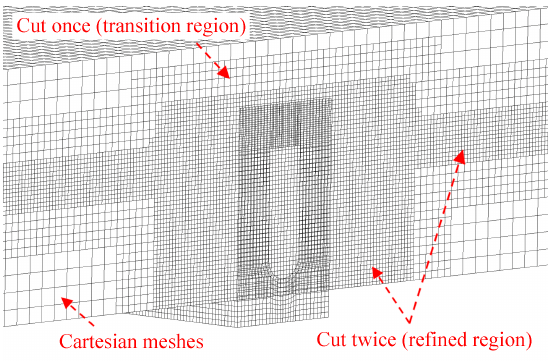
Figure 7. The cut-cell elements in transition region (4–6 grid layers in z -direction) and refined region (12 grid layers in z -direction near the water surface).